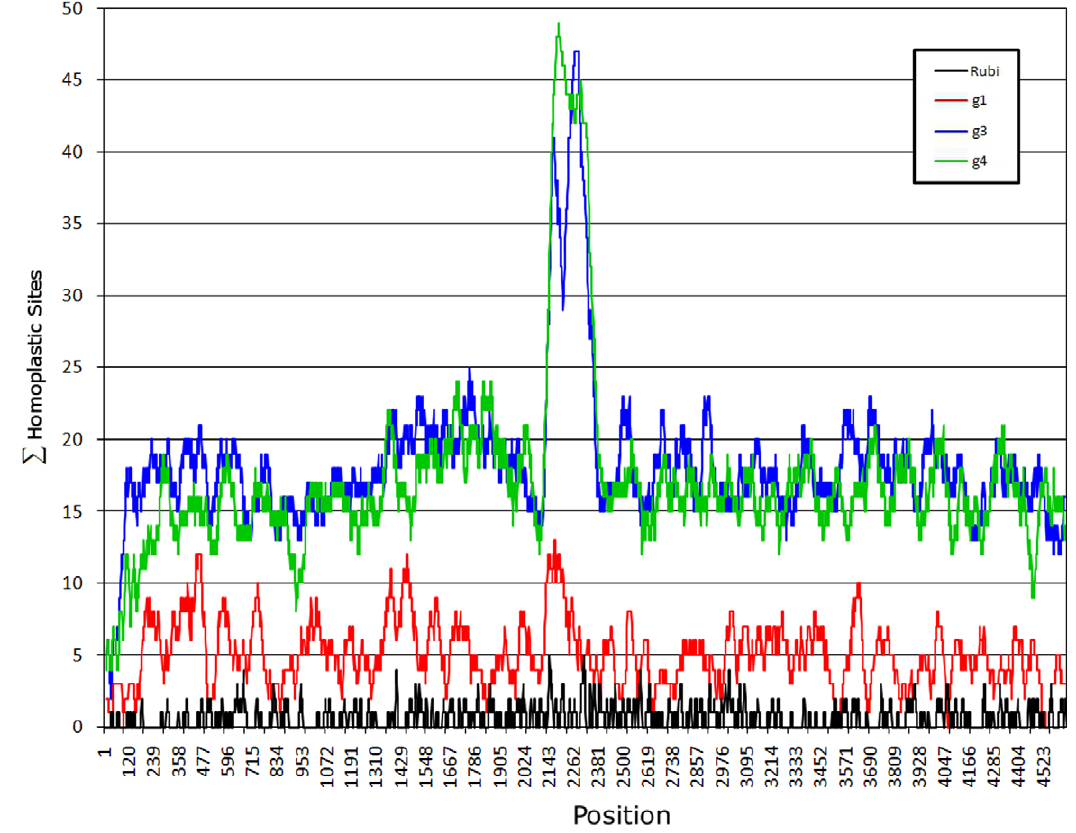
Figure 3. Homoplastic density. A sliding window was used to count the number of aa within each window having a homoplastic index of $ 0.5 (shown on the left). Numerals below y axis represent nt positions in